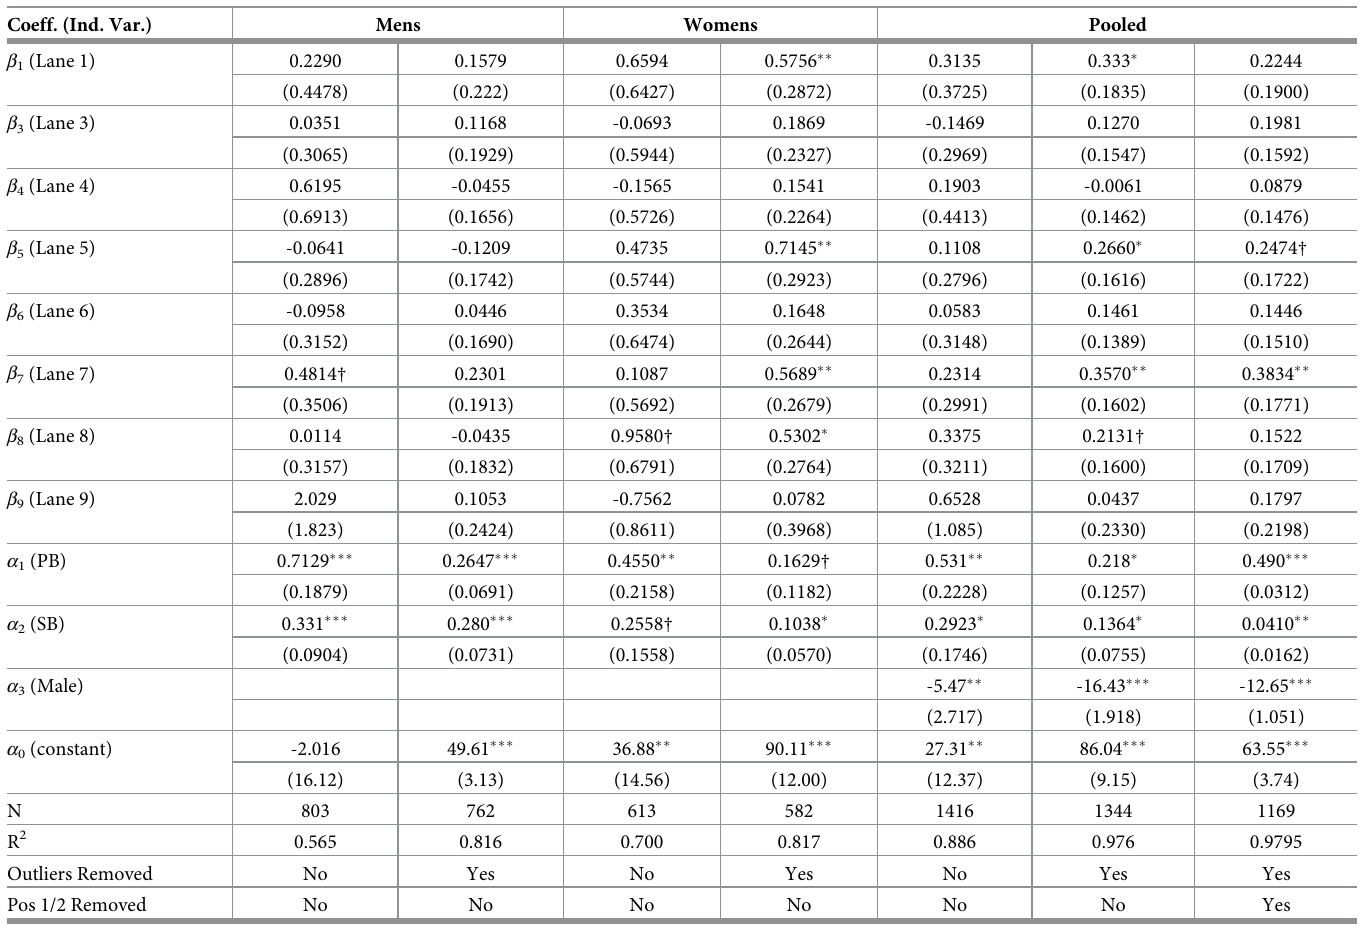
Table 5. Regression results for 800m. Coeff. (Ind.